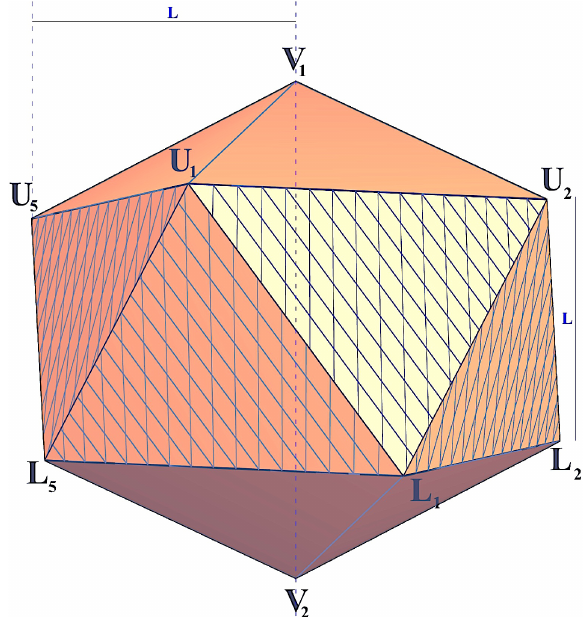
) and three of the lower pentagon vertices 1 , 2 , 5